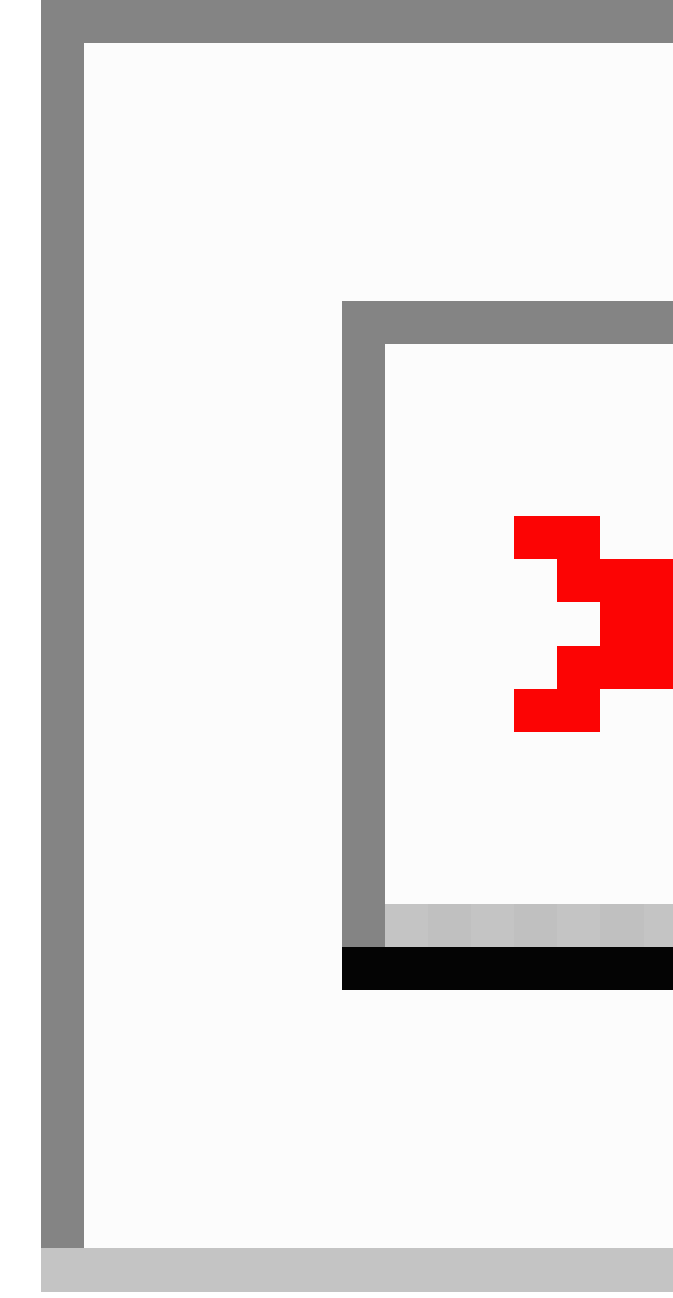
Figure 2. Poll on Healthy.me (University of New South Wales,